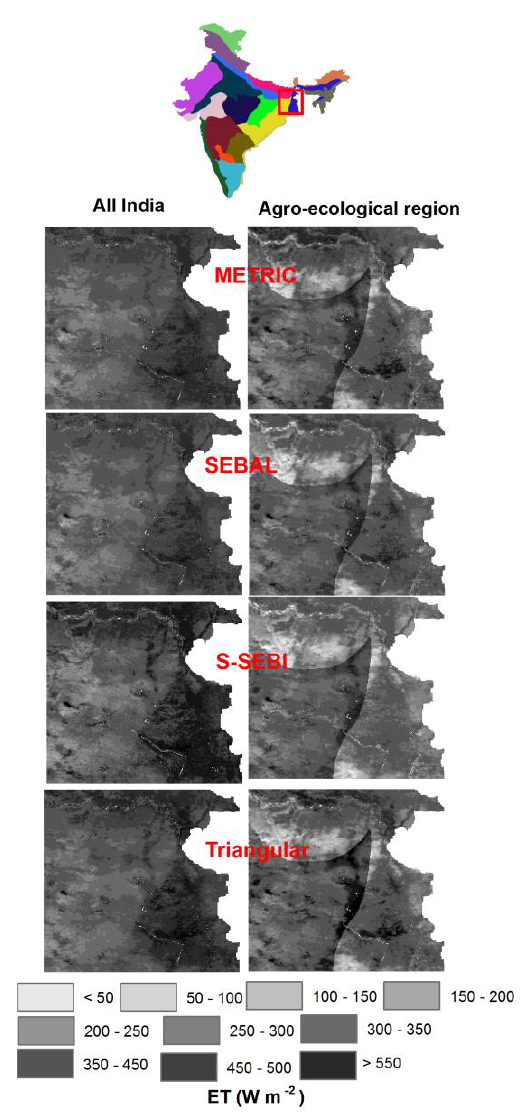
Figure 4. A zoomed-in view of ET maps for Eastern India for March 12, 2005 using all India and agro-ecological region as the spatial domains for the implementation of four contextual remote sensing based SEB